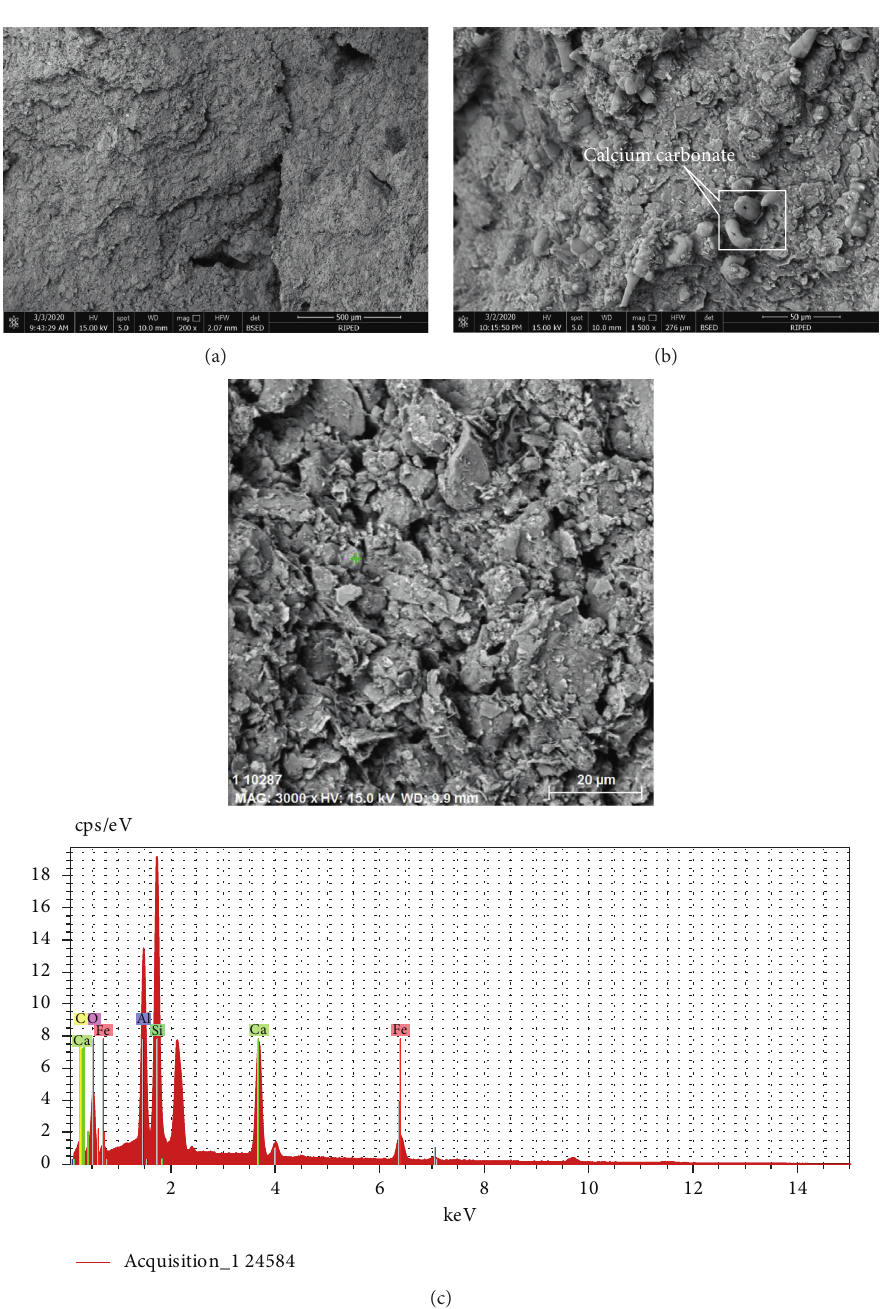
Figure 8: SEM/EDS images of MICP-treated soft clay. (a) Voids and fissures in soft clay. (b) SEM image of calcium carbonate precipitation in soft clay. (c) The EDS test